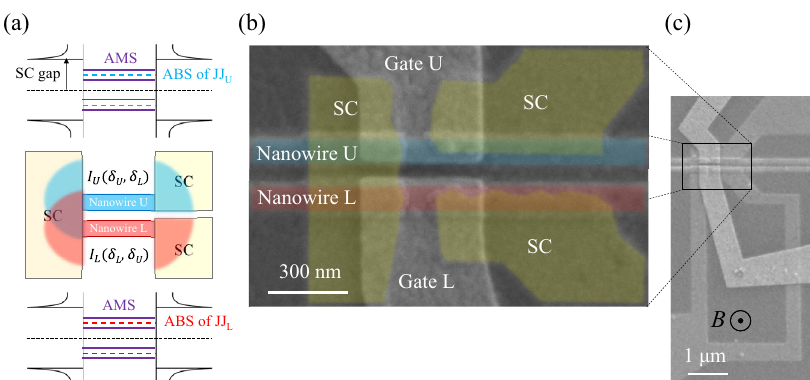
Fig. 1 Concept of this study and device structure. a AMS formation is shown. The ABSs of JJU and JJL penetrate the SC electrodes, as illustrated in the middle panel. When the separation of the two JJs is short, the ABSs in the respective nanowires are hybridised to form an AMS. b SEM image of the 3-terminal JJ on a double nanowire. The two JJs share the left SC electrode, but on the right side, the two SC electrodes were placed on the respective nanowires. c SEM image of sample B. The shared and lower SC electrodes in b are connected by a superconductor